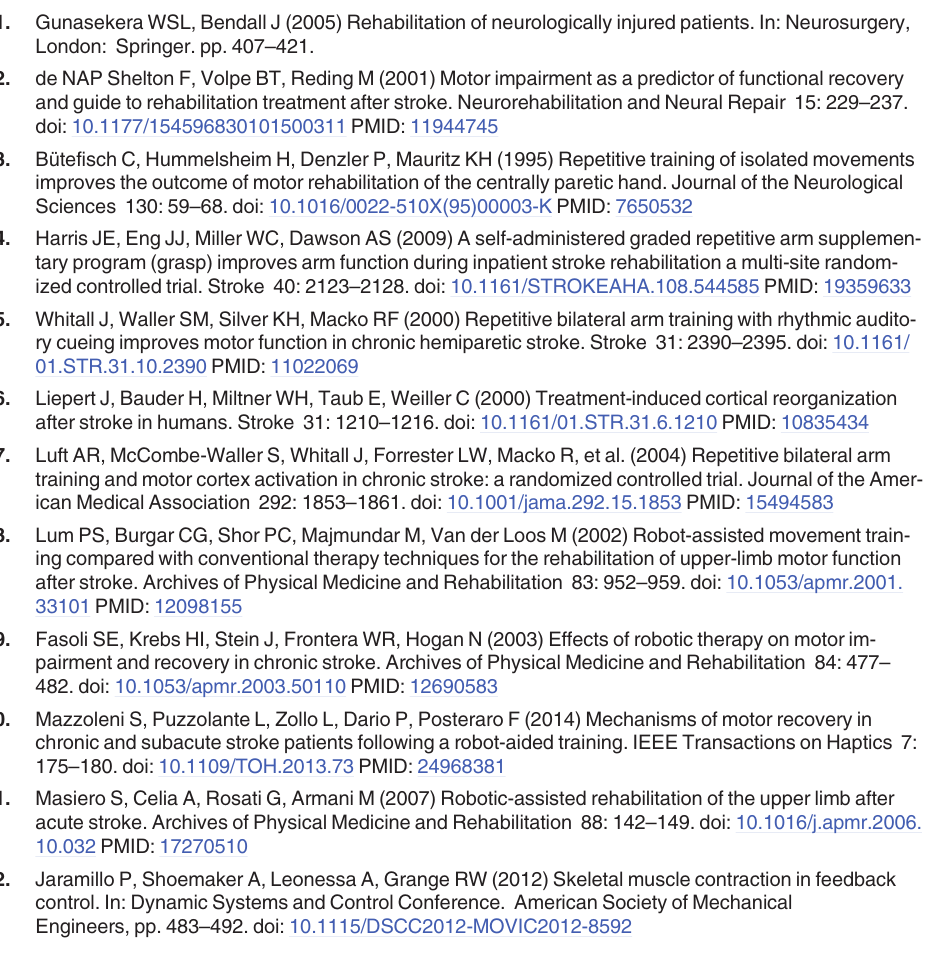
S1 Table. Participant survey